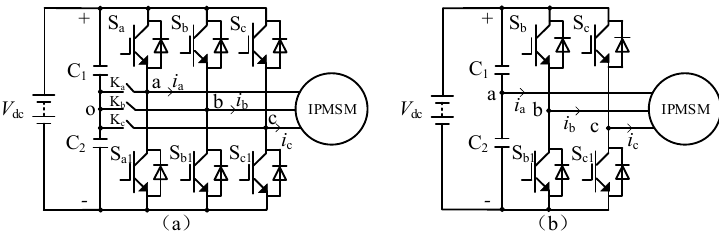
Figure 1. Speed regulation system of EVs on the basis of IPMSMs ( a ) 2L-VSI ( b ) 3P4SI.